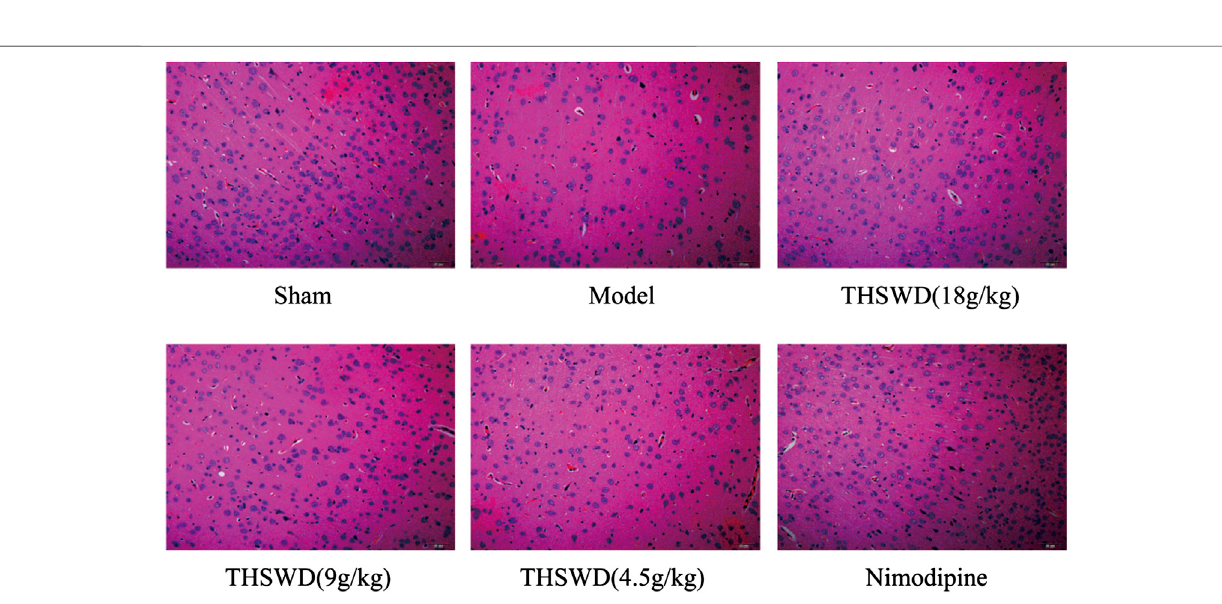
Frontiers in Pharmacology |